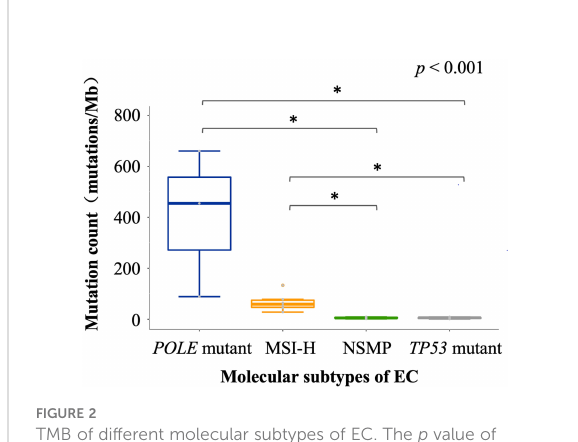
FIGURE 2 TMB of different molecular subtypes of EC. The p value of Kruskal-Wallis test for overall comparison is given, and signi fi cant levels in pairwise comparisons are shown in the fi gure. In the comparisons, n = 3 for POLE mutant, 6 for MSI-H, 10 for NSMP, 11 for TP53 mutant. The dot above the boxplot indicates an outlier. MSI-H, microsatellite instability high; NSMP, no speci fi c molecular pro fi le; EC, endometrial cancer; TMB, tumor mutation burden. * p <